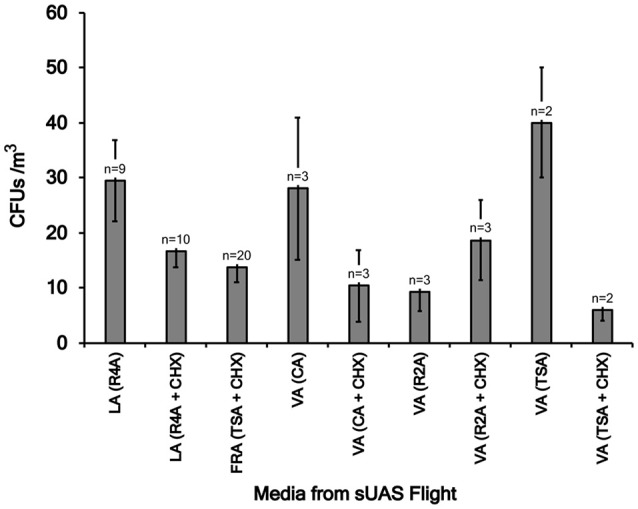
Mean colony forming units (CFUs) on eight different types of media (R4A, TSA, R2A, and CA, with and without 50 mg/L cycloheximide, CHX) for sUAS flights conducted in Louisiana (LA), France (FRA), and Virginia (VA). Mean CFUs were determined for a group of flights in the same location and where the samples were collected on the same media type. The lowest CFU value was 22 taken at Virginia on TSA + CHX media. The highest CFU/mL value were 148 and 146, taken at Virginia (on TSA media) and at Louisiana (on R4A media), respectively.